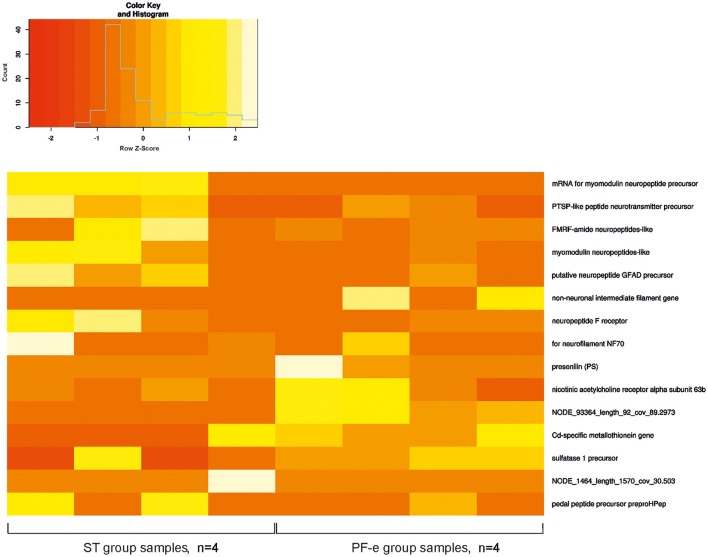
The heatmap for FPKM value of most significant differential expression genes.